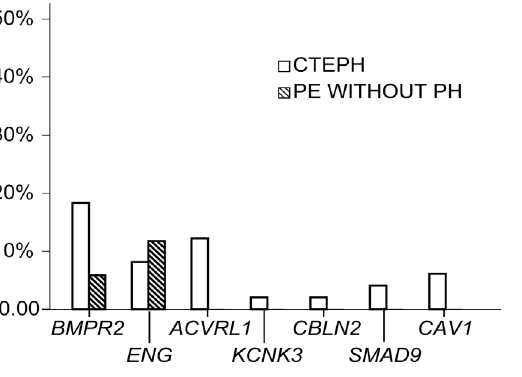
Fig 1. Distribution of nonsynonymous mutations of 7 pulmonary arterial hypertension-causing genes in chronic thromboembolic pulmonary hypertension patients and patients recovered from pulmonary embolism and without pulmonary